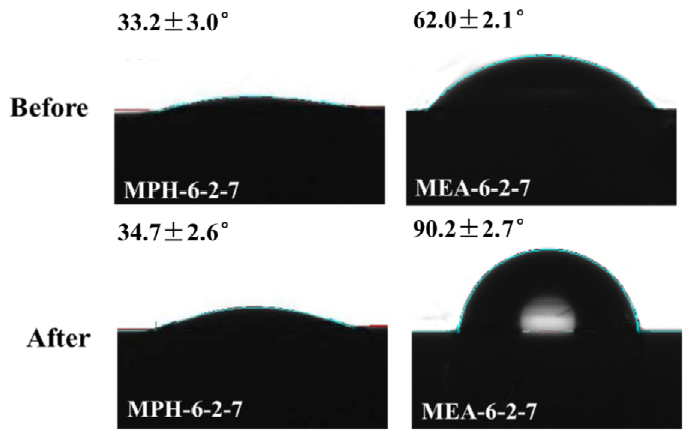
Figure 10. Contact angle images of MPH-6-2-7 and MEA-6-2-7 before/after cleaning in 500 mg/L NaClO solution for 16